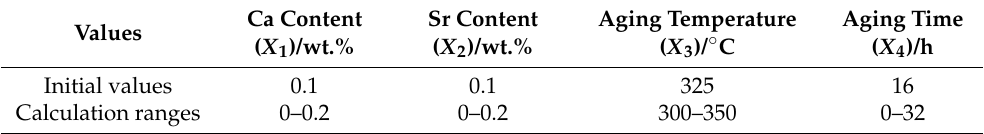
Table 3. Initial values and calculation ranges of separate